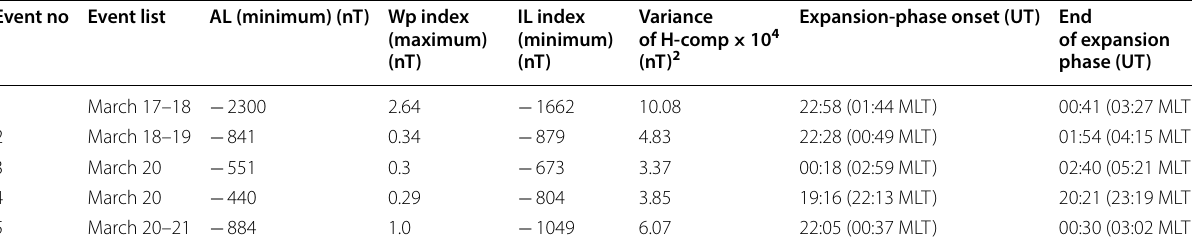
Table 2 List of substorms in the St. Patrick’s Day 2015 geomagnetic storm and the duration of their expansion phases have been derived from ground magnetic perturbations reflected in AL index, Wp index, IL index and H-component of geomagnetic disturbances